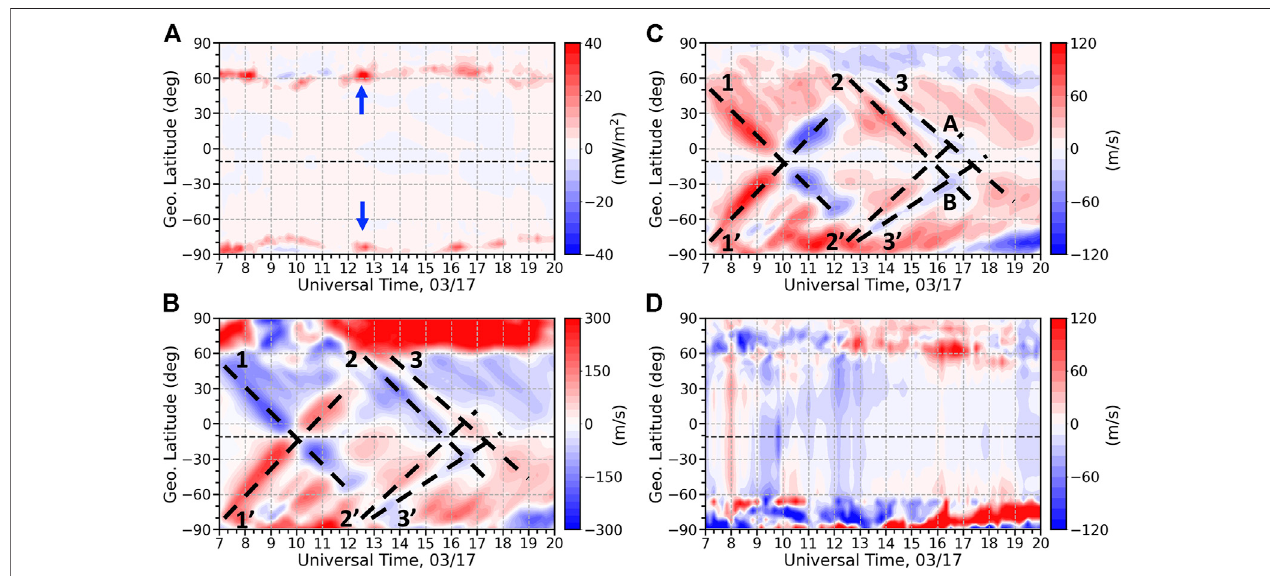
FIGURE 6 | Storm-quiet differences of (A) Joule heating, (B) meridional neutral wind, (C) vertical ion drift associated with the neutral wind and (D) vertical ion drift associated with the electric fi eld at 300 km and at 70 ° W. Positive neutral wind corresponds to northward neutral wind, and positive ion drift correspond to upward ion drift.Allparametersarepresentedasafunctionofuniversaltimeandgeographiclatitude.Thethinblackdashedlineineachpaneldenotesthegeomagneticequator.The thick black dashed lines highlight the TADs. TAD, traveling atmospheric disturbance. (A) Δ Joule heating. (B) Δ Vn. (C) Δ Vi (wind, up). (D) Δ Vi (ExB,